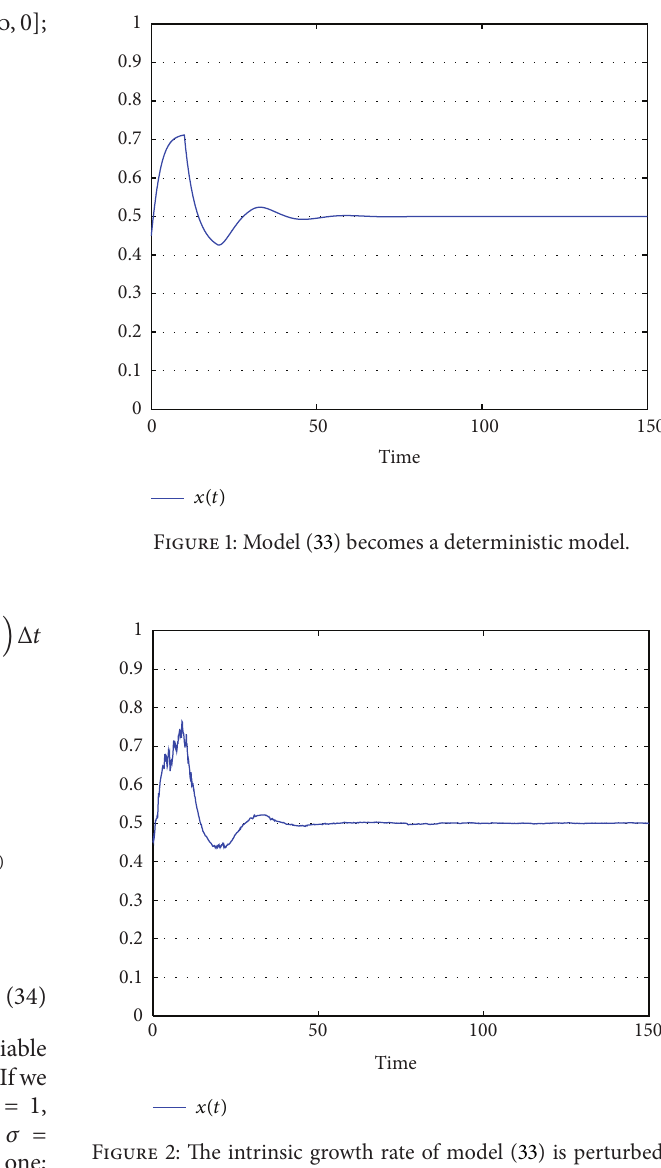
Figure 2: The intrinsic growth rate of model (33) is perturbed by white